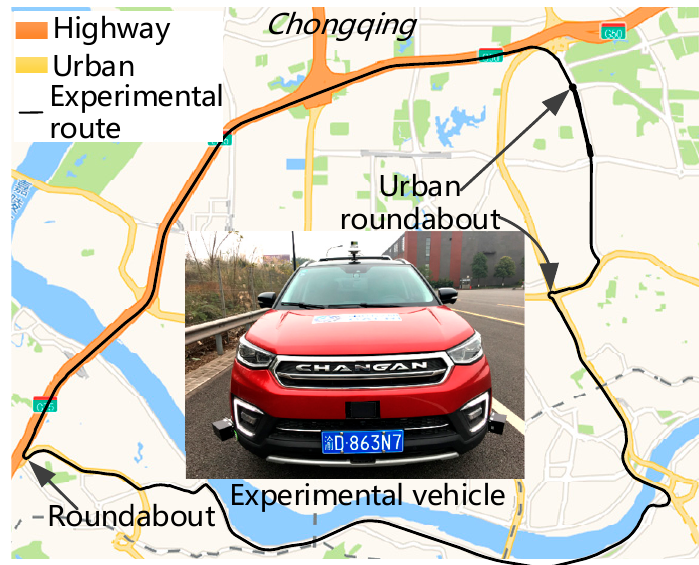
Figure 1. Trajectory for collection of natural driving data.